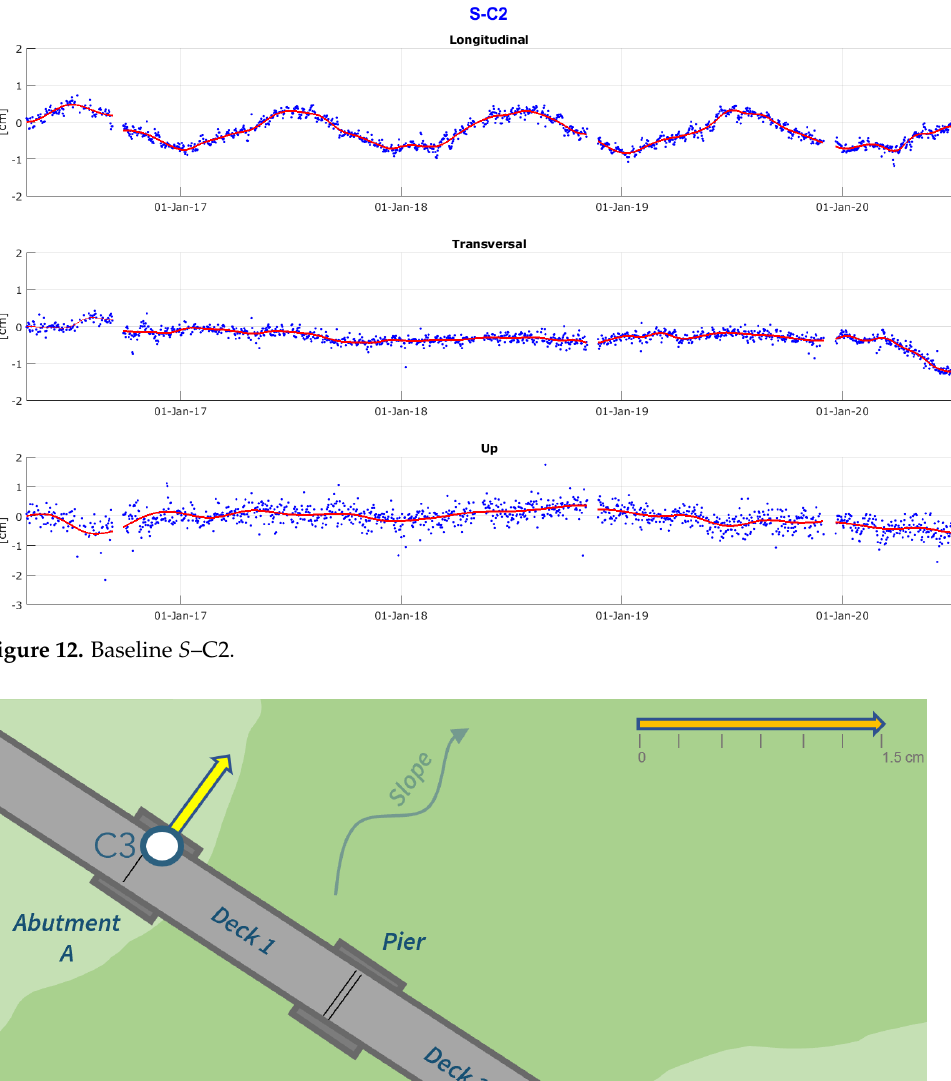
Figure 13. X and Y components on the baseline S –C3 with the X -axis oriented along the steepest descent direction of the